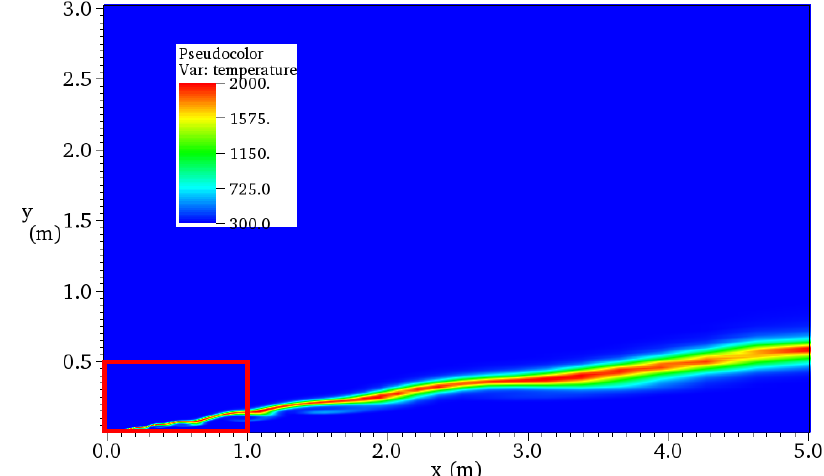
Figure 14. Initial temperature contours in the cross section at 0 z =